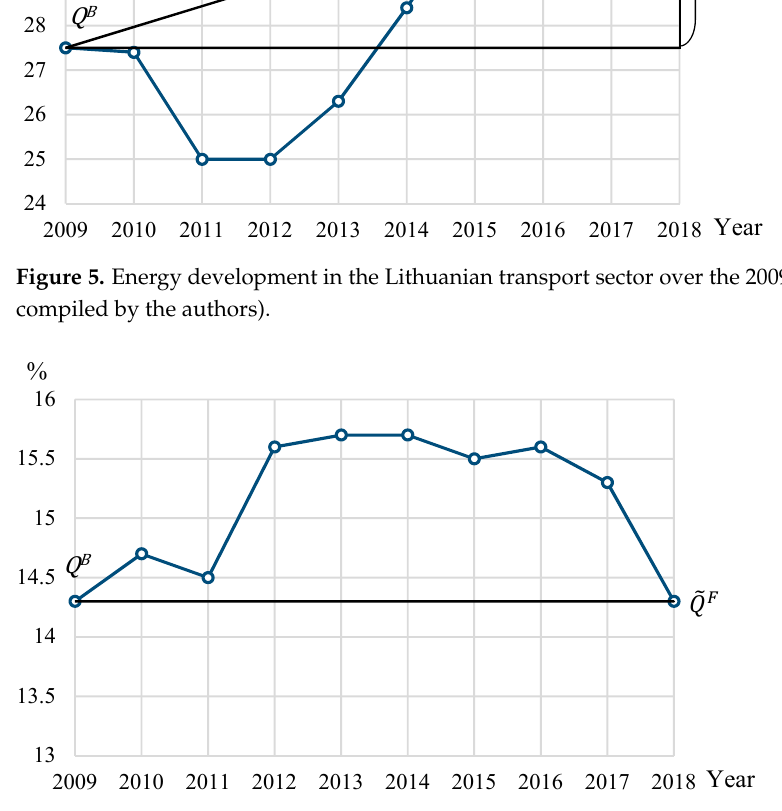
Figure 6. Energy development in the Latvian service sector over the 2009–2018 period (source: compiled by the authors).